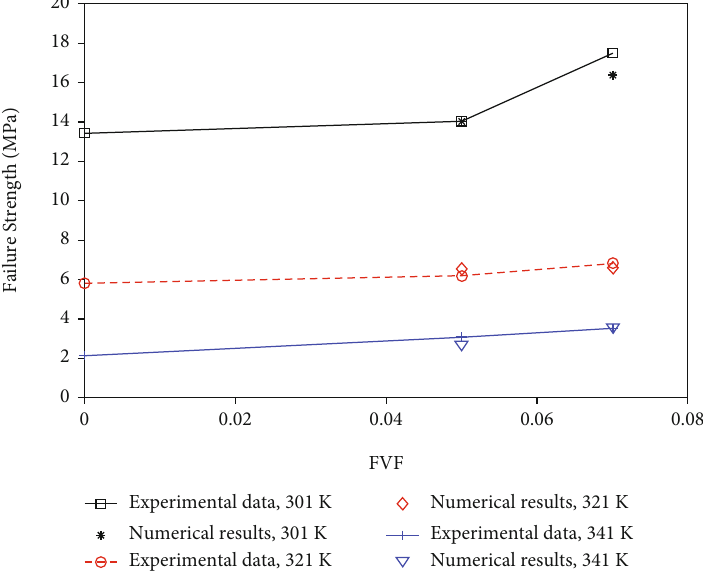
Figure 8: Investigations of the failure strength with respect to the FVF variations at di ff erent ambient